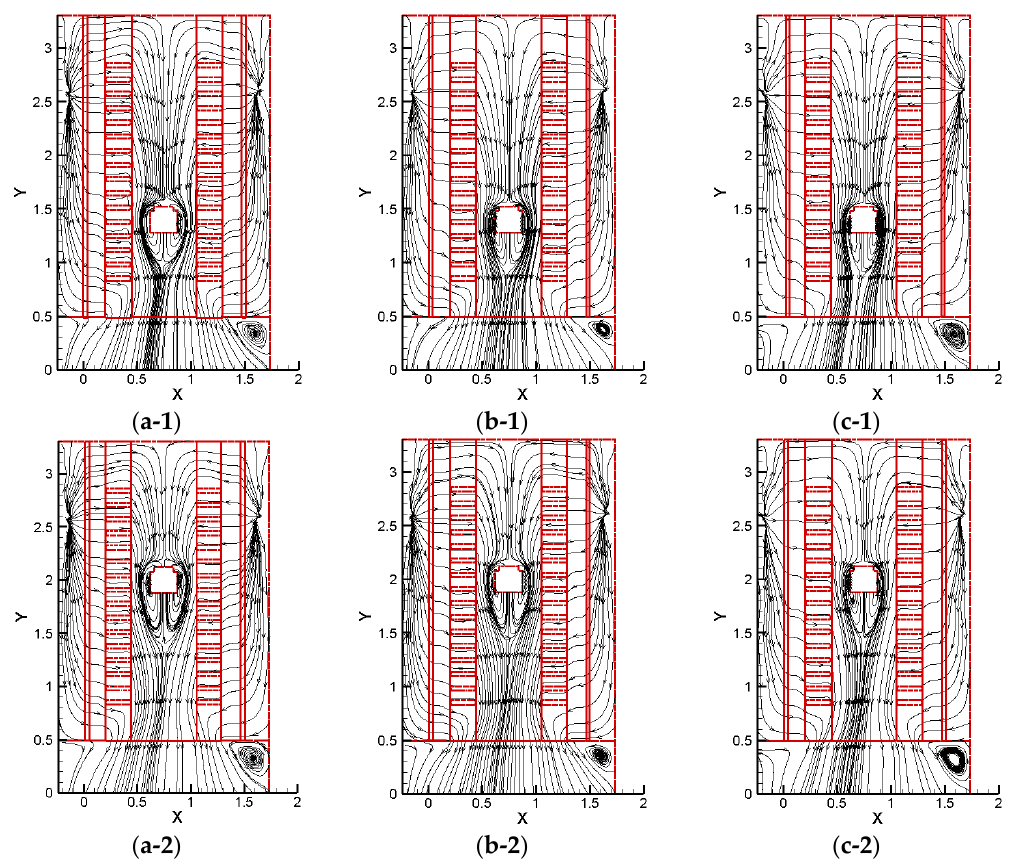
Figure 6. Evolution of the X-Y cross section airflow distributions (at Z = 2.81 m) while a crane moves (with a velocity of 0.4 m/s) along the Y axis with an inlet airflow velocity of ( a ) 0.08 m/s; ( b ) 0.12 m/s, and ( c ) 0.16 m/s at different locations. Here, 1 and 2 of sub-figures stand for the different location of the Y axis. To investigate the distribution of the released particle in the stocker, it is assumed that particles were induced by the crane moving along the Y axis. At different inlet airflow velocities, the crane was assumed to move vertically at 0.4 m/s along the Y axis; at a predetermined time, 10,000 particles with a diameter of 0.01 μ m were released from the bottom at the position Y = 0.68 m. The particle release